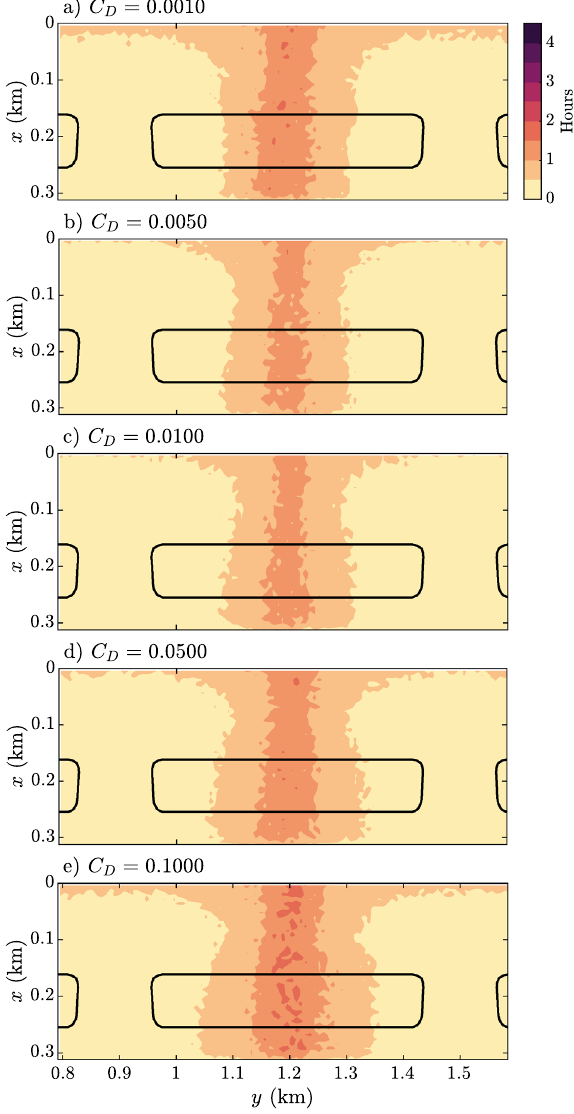
Figure 6. Depth-averaged residence times of particles released an hour before low tide. Solid black lines indicate reef flat